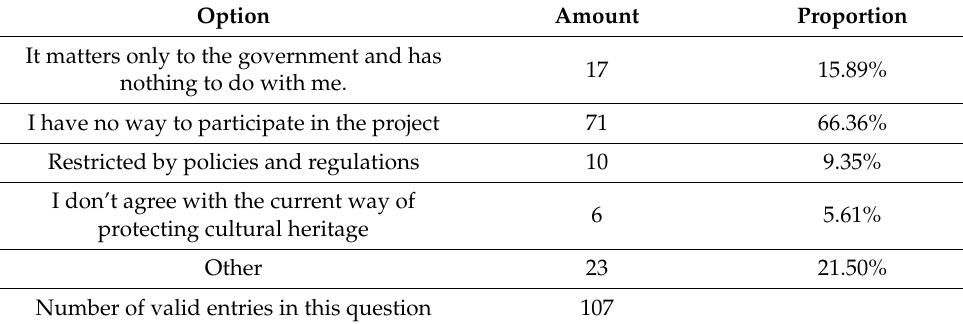
Table 14. The reason for unwillingness to invest in the renovation of construction projects.